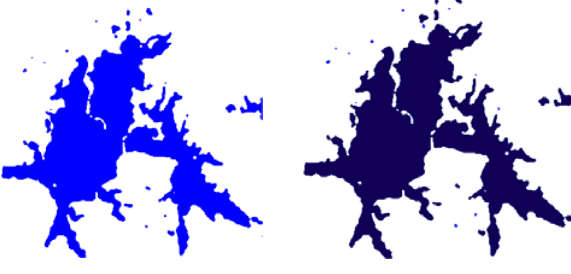
Figure 12. Filling the blanks of TM image with translated